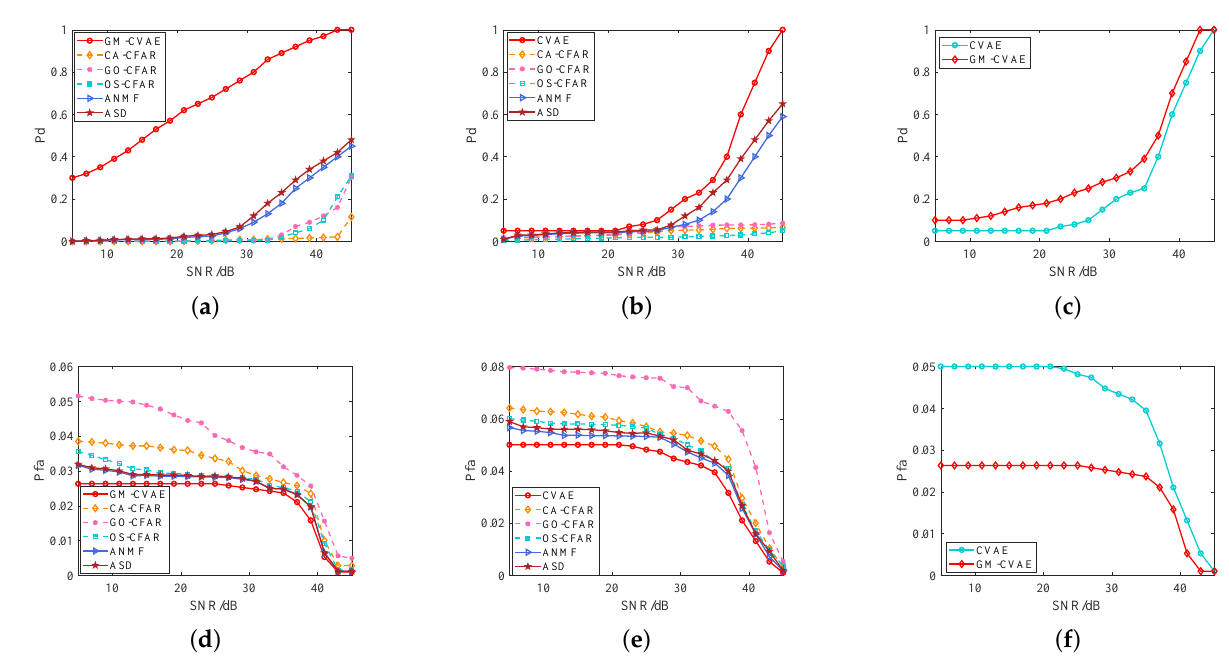
Figure 11. Single-scene performance for Type-2 clutter without MTI filter: Comparison of detection probability ( a ) between GM-CVAE and CA-CFAR, GO-CFAR, OS-CFAR, ANMF and ASD methods; ( b ) between CVAE and the five traditional detection methods; ( c ) between GM-CVAE and CVAE; Comparison of actual false alarm rate ( d ) between GM-CVAE and the five traditional detection methods; ( e ) between CVAE and the five traditional detection methods; and ( f ) between GM-CVAE and